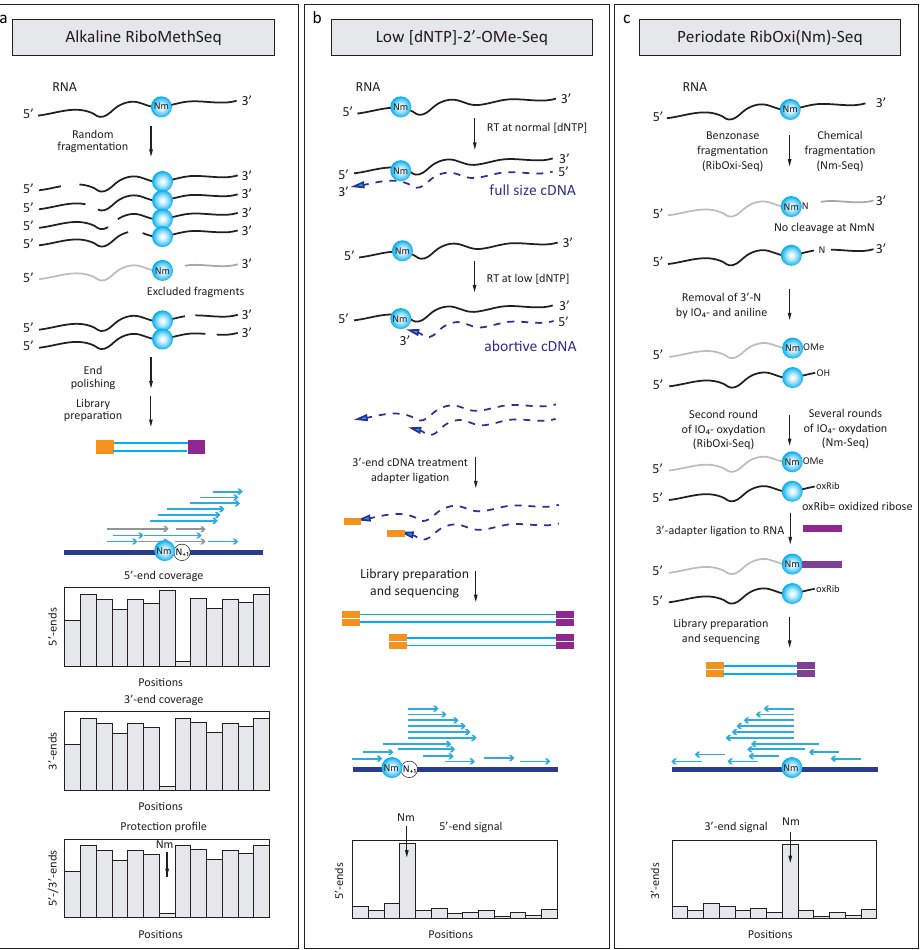
Figure 4. Deep sequencing-based approaches for detection of 2 (cid:48) - O -methylated residues in RNA: ( a ) Alkaline fragmentation of RNA used in RiboMethSeq excludes RNA fragments ending with 2 (cid:48) - O -Me and, subsequently, also starting with N + 1 nucleotide. After conversion to the sequencing library these fragments become underrepresented (shown in grey). When sequencing reads are mapped to the reference sequence, 5 (cid:48) -end and 3 (cid:48) -end coverage show a characteristic drop, resulting from protection. These profiles are merged together (with -1 nt backshift for the 5 (cid:48) -end coverage) to give a cumulated profile used for calculation of RiboMethSeq scores; ( b ) Detection of 2 (cid:48) - O -Me dependent RT stops by 2 (cid:48) -OMe-Seq. Primer extension is done on the same RNA template under normal and reduced [dNTP] and specific low-[dNTP] signals are detected after sequencing and mapping of reads’ 5 (cid:48) -ends; ( c ) Periodate oxidation-based methods for 2 (cid:48) - O -Me detection (RibOxi-Seq and Nm-Seq). RNA is fragmented chemically or by nuclease and exposed to periodate oxidation. Cis -diols of